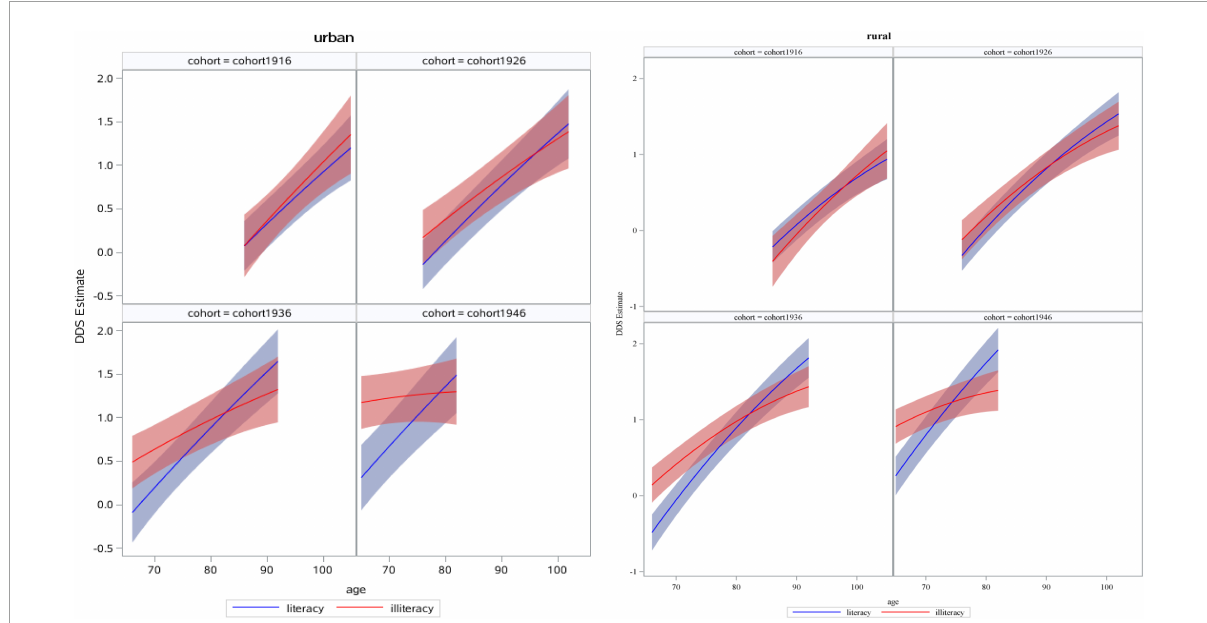
FIGURE2 Estimated dietary diversity score (DDS) of education with age and across successive cohorts in urban and rural older adults.